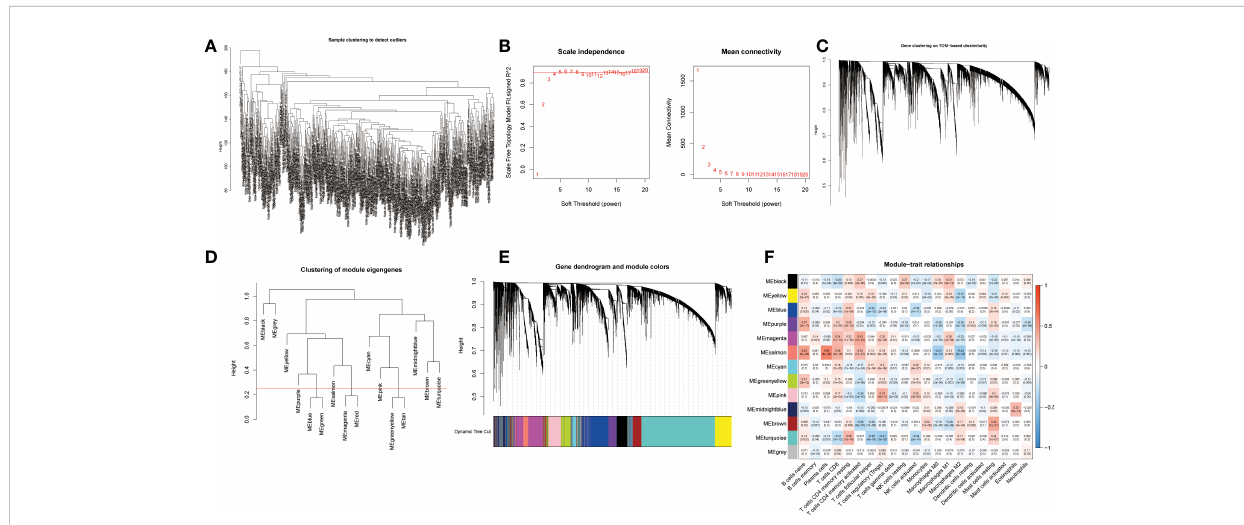
FIGURE 2 WGCNA of differentially expressed genes. (A) Sample clustering for detecting outliers. (B) Scale-free topology fi tting index at different threshold values and mean connectivities. (C) Gene clustering on TOM-based dissimilarity. (D) Clustering of module eigengenes. (E) Gene dendrogram and module colors; (F) Module-trait relationships. Thirteen rows correspond to distinct co-expression modules, and twenty-one columns correspond to 21 types of in fi ltrative immune cells. The corresponding correlation coef fi cient and p-value for each type are shown in the